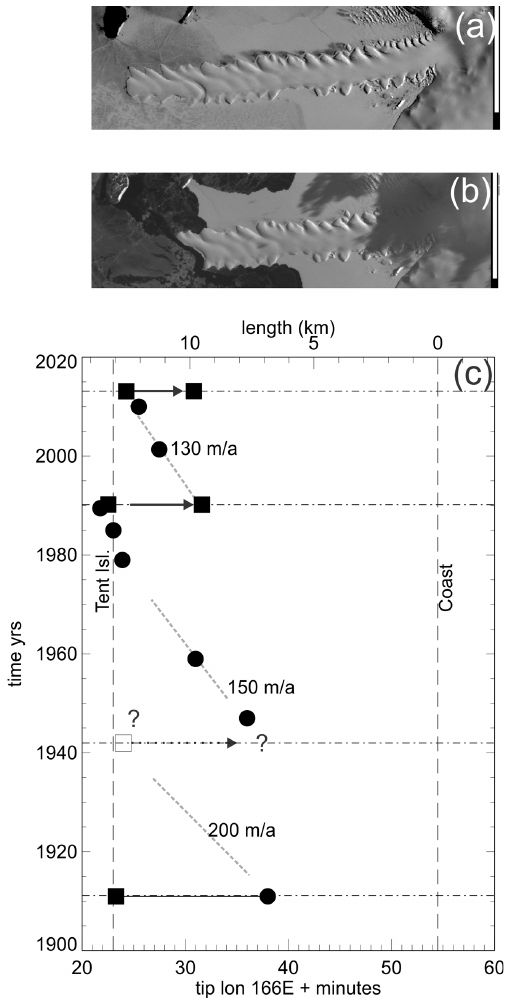
Fig. 2. ASTER images of EGT (a) before and (b) after the 2013 calving (zoomed from Fig. 1a, b), and (c) tip space-time diagram. The longitudes of Tent Island and the coast are marked with dashed lines. The indicated tip velocities are the slope of the dashed lines. Squares show longitude at calving (hollow square indicates the date is poorly constrained) whilst circles are tip positions at other times. The 1911/1912 data come from Taylor (1922), the 1940s estimates are from Holdsworth (1982), the 1950–1990 data from a mix of USGS aerial photographs, DeLisle et al. (1989) and vessel observa- tions (Jacobs et al., 1981). The more recent data come from ASTER satellite